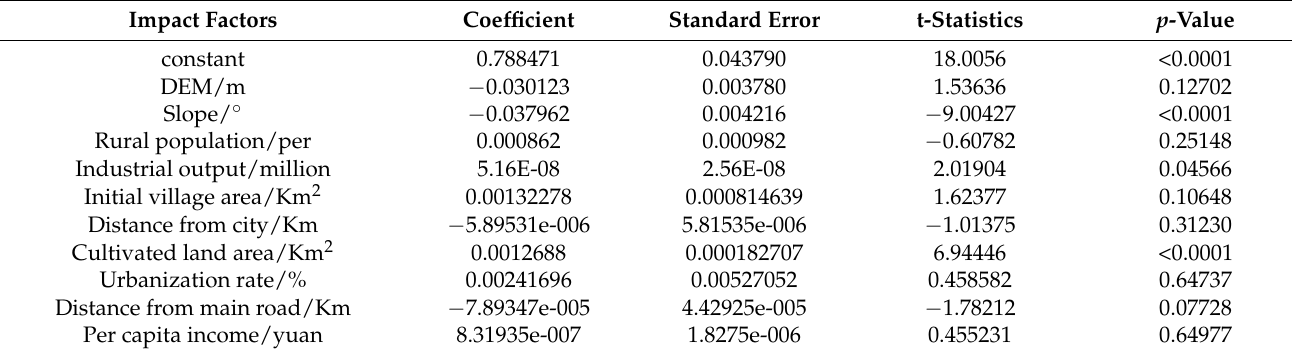
Table 3. OLS model calculation results (2019).